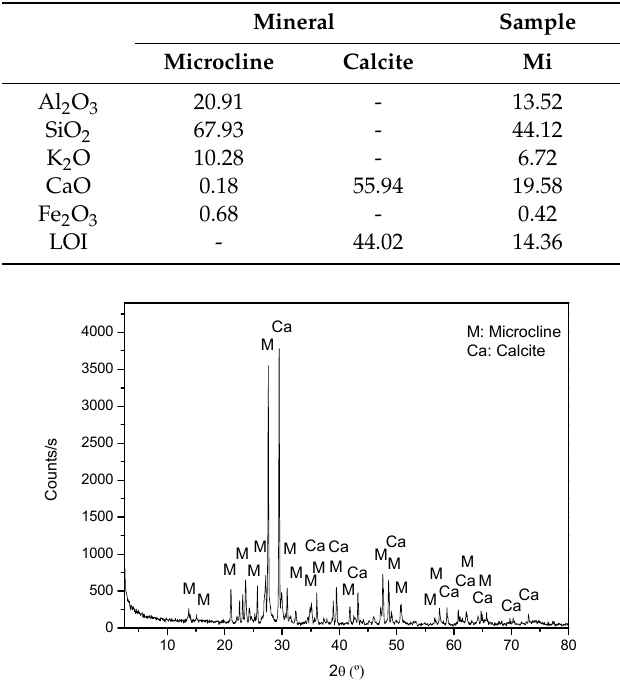
Figure 1. XRD pattern of the Mi sample.